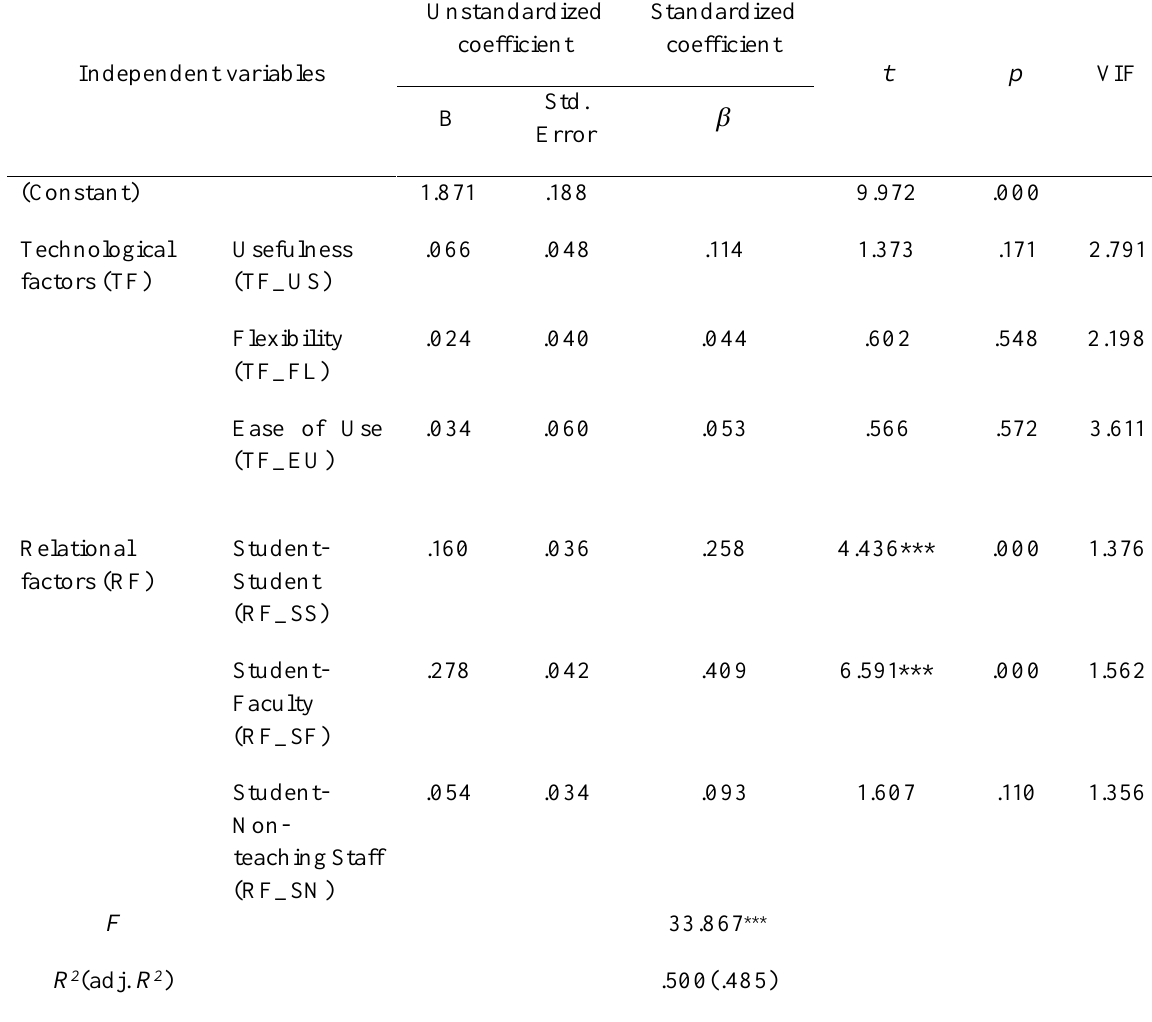
Independent variables